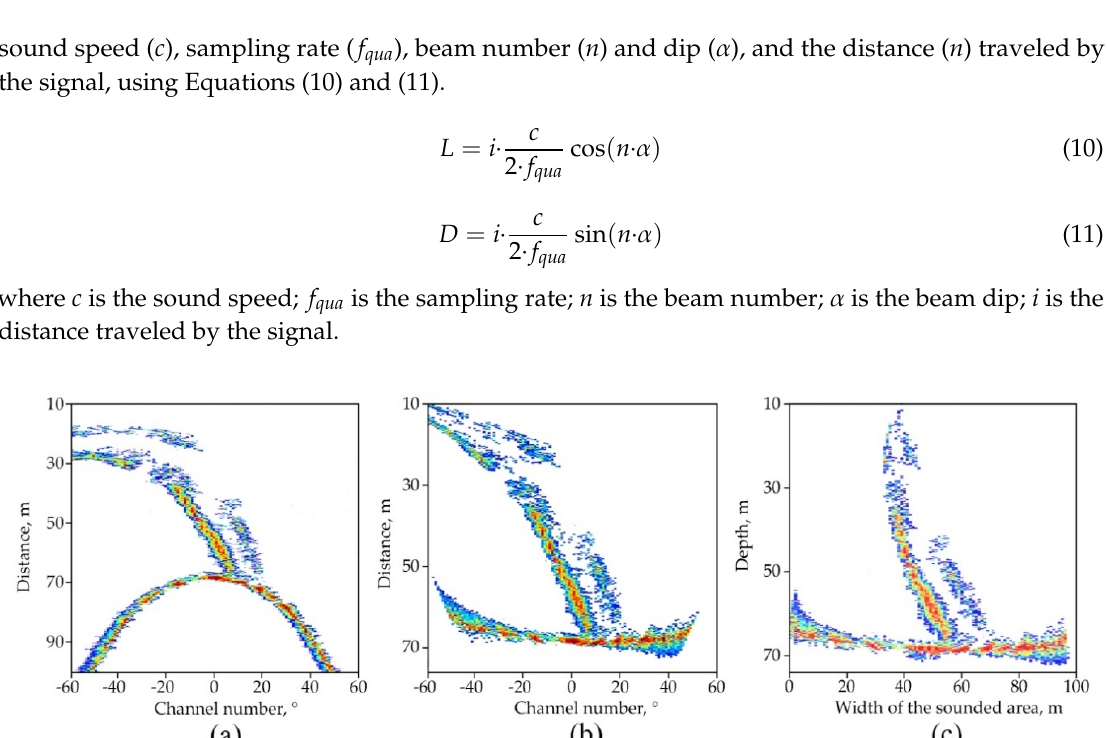
Figure 3. Simrad EK15 calibration: temperature and salinity profiles ( a ); observed (red line) and averaged (blue line) frequency dependence of target strength ( (cid:1846)(cid:1845) ) ( b ).